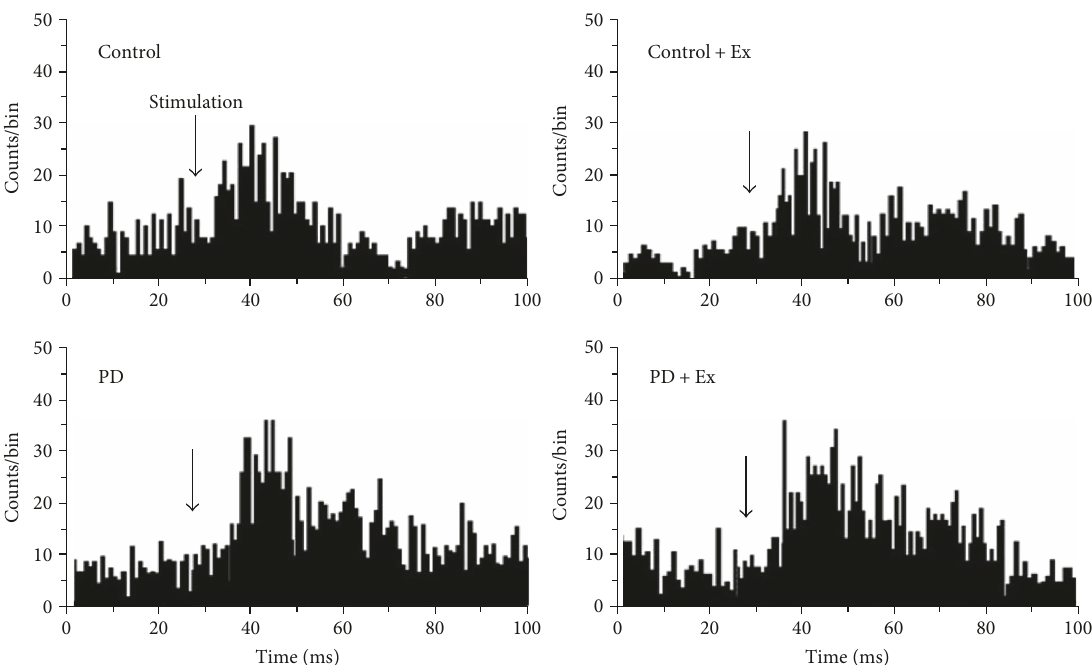
Figure 9: Comparison of evoked latency of striatal neurons after cortical stimulation. The latency was signi fi cantly decreased in the PD compared to the control group. Note that the latency in PD+ Ex rats is signi fi cantly attenuated by treadmill exercise; exercise can reverse 6-OHDA-induced hyperactivity of the corticostriatal glutamatergic pathway. Control: control group; control +Ex: control plus exercise group; PD: Parkinson ’ s disease group; PD +Ex: Parkinson ’ s disease plus exercise group; 6-OHDA: 6-hydroxydopamine.